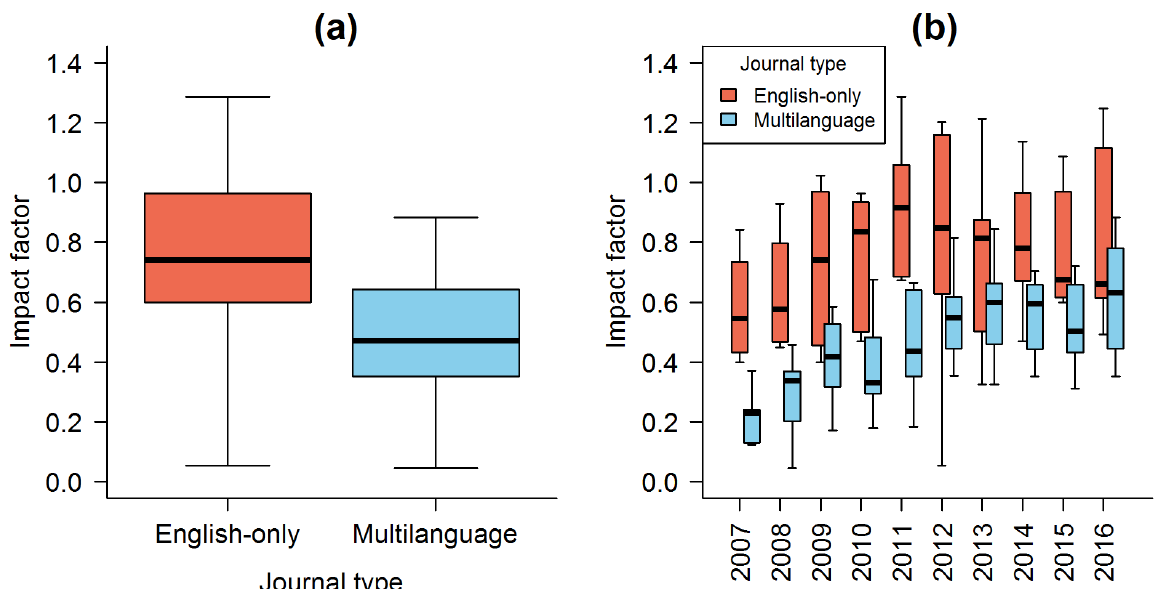
Figure 1. Relationship between impact factor (cites per document in the past two years), journal types and time. (a) Journals that have consistently published in English had the highest impact factors. (b) In both journal types, the impact factor ascended in time, but in general English-only journals had consistently higher IF valuers than their multilanguage counterparts. First (lower line) and third (higher line) quartiles, the median (bold line), upper and lower limits (projected